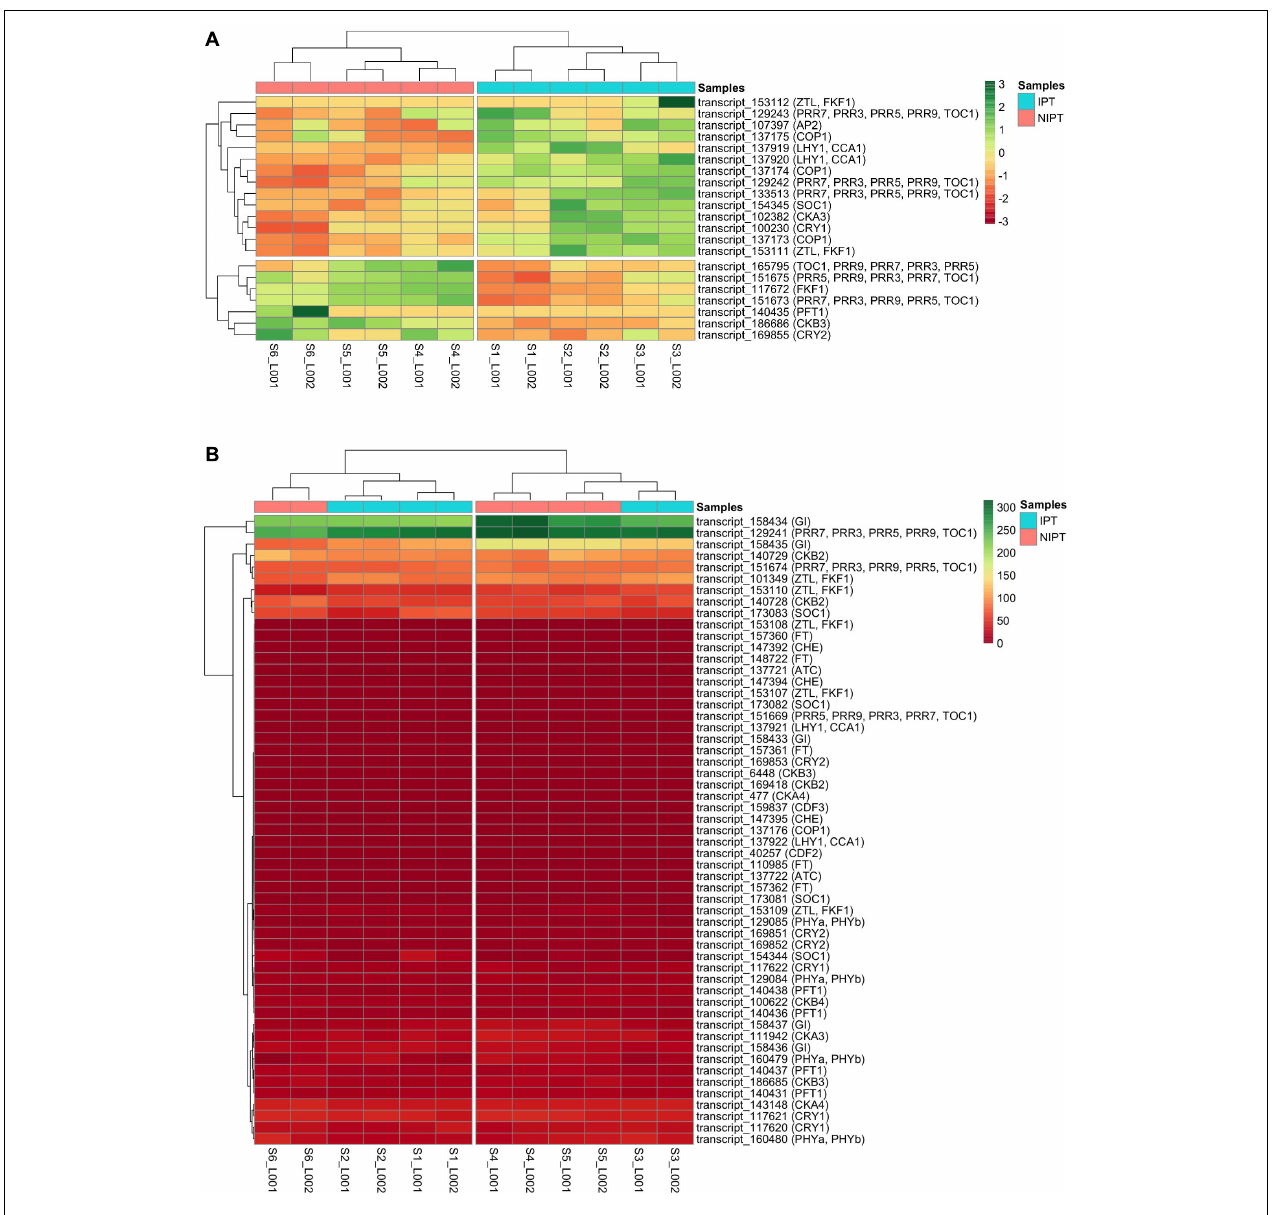
FIGURE 2 | Expression-based clustering of sugarcane orthologs of photoperiodic and flowering genes. Transcripts with (A) and without (B) DE were color-coded (red to green) by the FPKM values in 12 samples (six for each condition). In panel A, the data were centered and scaled. Euclidean distance was adopted in hierarchical clustering. IPT (Inductive photoperiodic treatment) and NIPT (Non-inductive photoperiodic